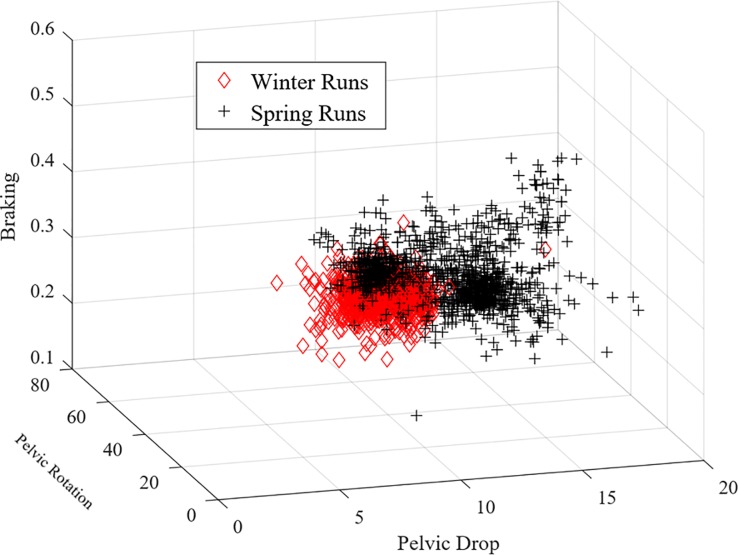
Graphical representation of the three most important variables (braking, PD and PR) for Runner 4 with Method 2.Each point is equivalent to five strides. Data from both the training and testing sets are shown.